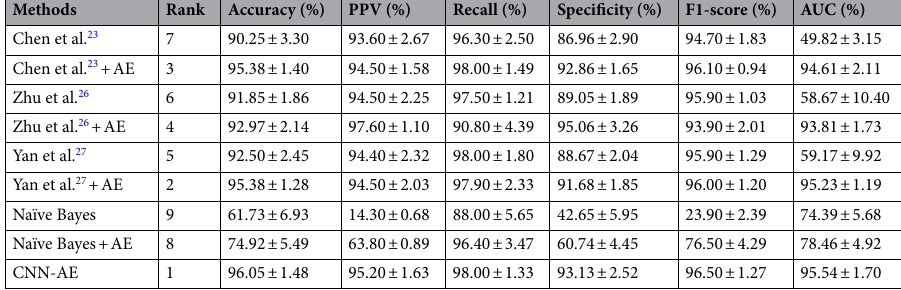
Table 9. Performance metrics for various classification algorithms with and without AE-based data